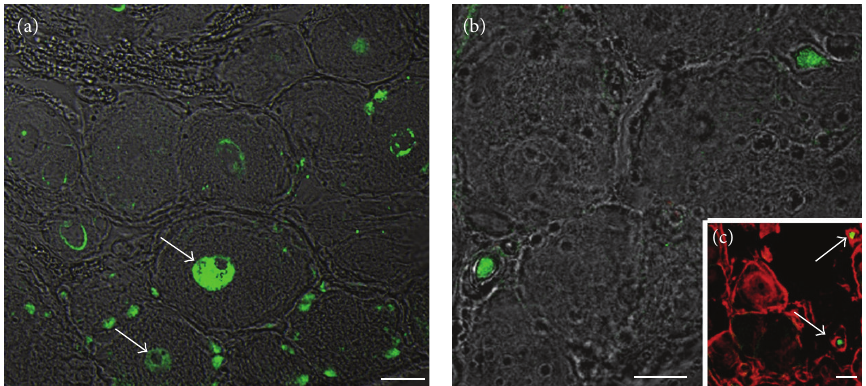
Figure 7: Immunofluorescence images of DRG after crush lesion and BrdU treatment for the qualitative evaluation. 15 days after crush lesion, many small cell nuclei surrounding ganglionic neurons as well as some nuclei belonging to sensory neurons are found to be BrdU-positive (a, arrows). Cells localized surrounding the ganglionic neurons are immunolabeled with Ki67, an endogenous marker for proliferation 3 days after crush lesion (b). A double labeling using anti-Ki67 (green) associated with anti-peripherin (red), 7 days after injury, shows a coexpression of the two markers in ganglionic neurons (c). Scale bars: a–c = 20 𝜇